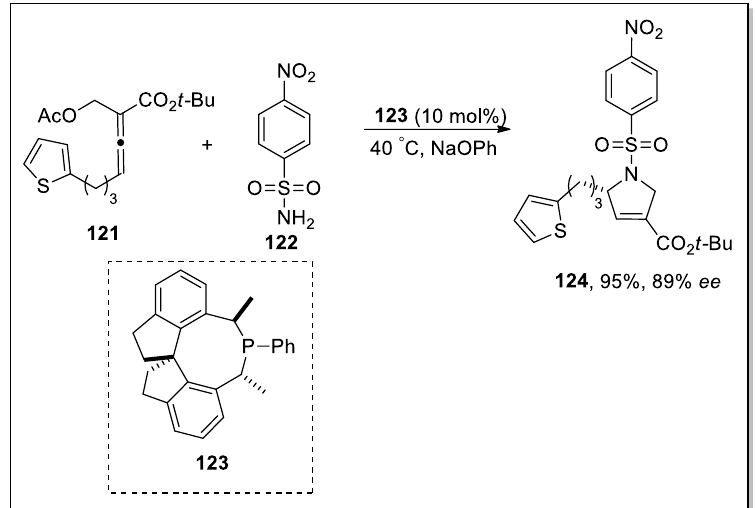
25 of 49 Scheme 34. Construction of spiro-benzofuranone derivatives 116 and 117 . An efficient and straightforward synthesis of P - stereogenic phosphines derived from carvone was published by Kwon and co-workers [65]. The synthesized organocatalysts were utilized in the asymmetric synthesis of several pyrrolines via the [3+2] annulation of allenes and imines. When allenoate 108 reacted with N -tosylbenzaldimine 118 in the pres- ence of p -anisyl phosphines 119 - S and 119 - R , it resulted in efsevin (a biologically active compound) enantiomers 120 - S (92%, 21% ee ) and 120 - R (93%, 84% ee ), respectively (Scheme 35). Scheme 35. Synthesis of efsevin 120 - S and 120 - R via [3+2] annulation. Due to the presence of five-membered N -heterocycles, a broad range of biologically active compounds, many procedures for the construction of these chiral heterocycles